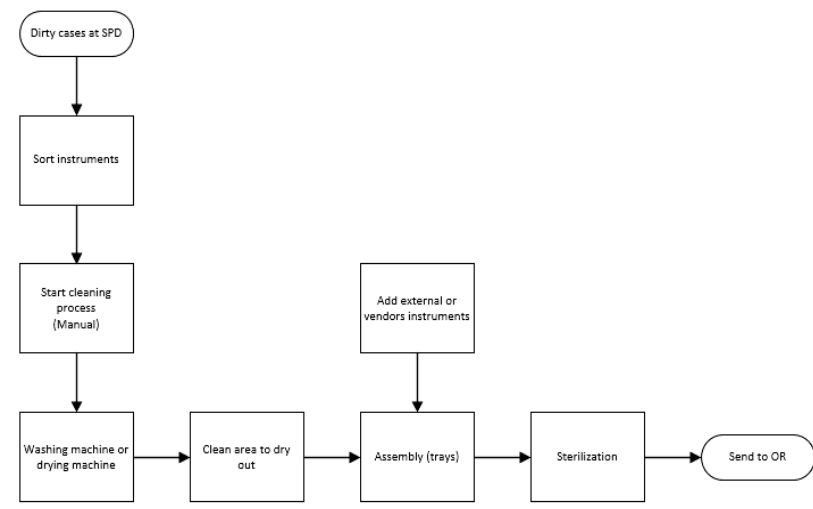
Figure 3. Sterile Processing Department (SPD) process flow chart.